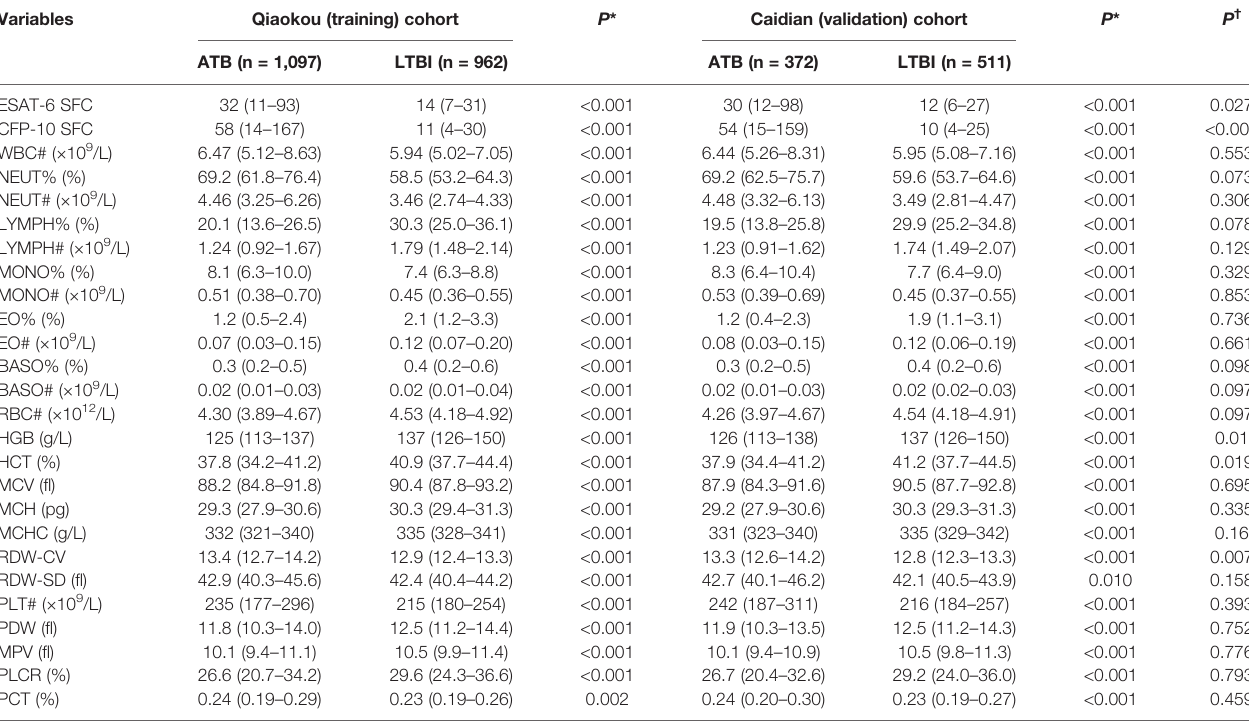
TABLE 2 | The results of T-SPOT and blood routine examination of the study participants.